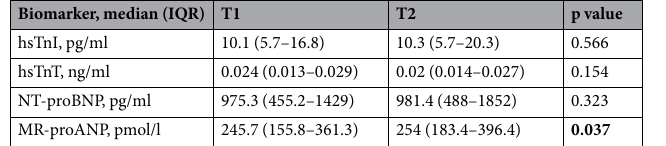
Table 2. Biomarker values of 42 patients at T1 and T2 after successful left atrial appendage occlusion. Values are given as median (25 th and 75 th percentiles). T1 = within 24 h prior to LAA closure, T2 = mid-term follow-up after LAA